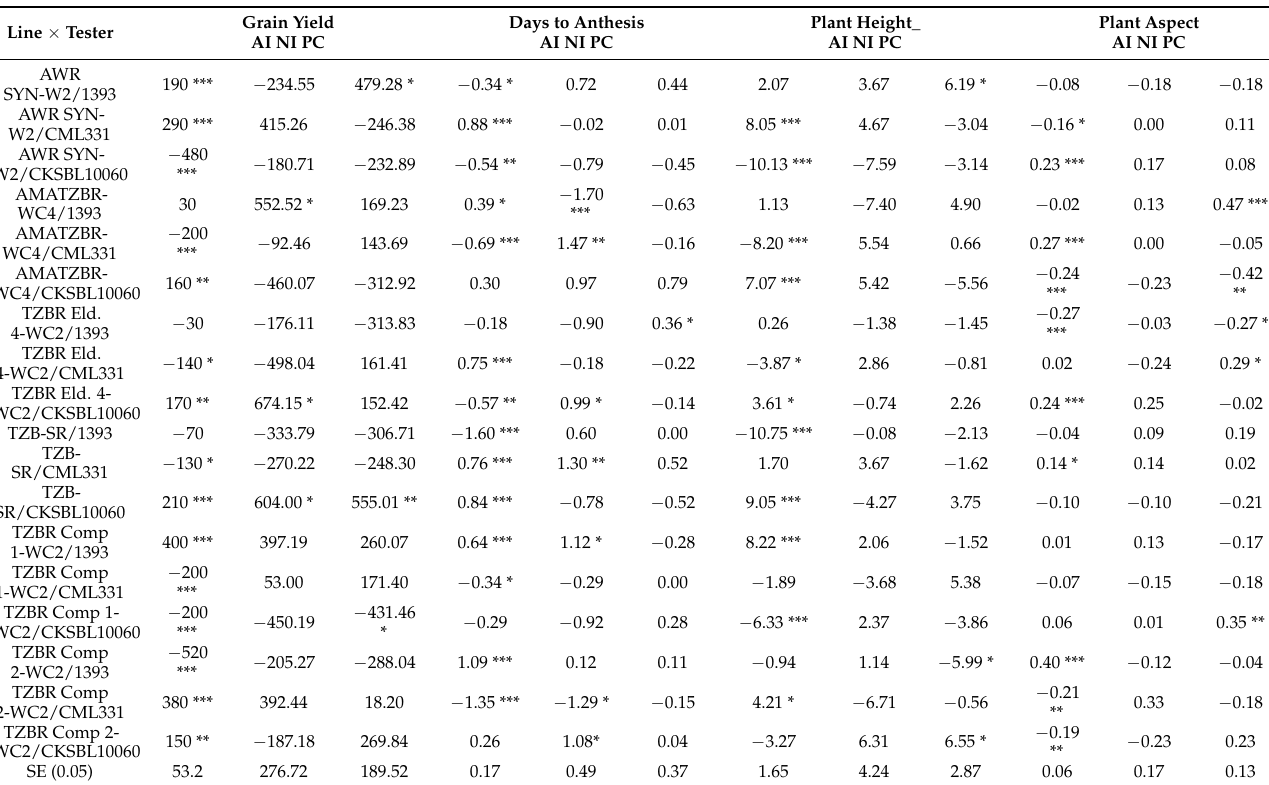
Table 6. Specific combining ability effects for grain yield, agronomic and fall armyworm (FAW)- resistant traits under FAW infestation and pesticide-protected conditions in